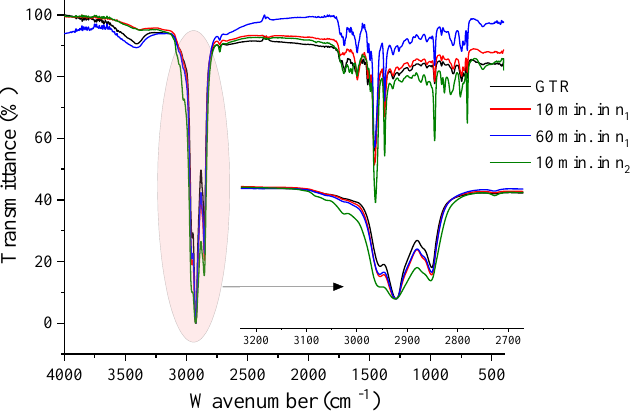
Figure 5. FTIR spectra for the soluble fraction of GTR after mechanochemical treatment.